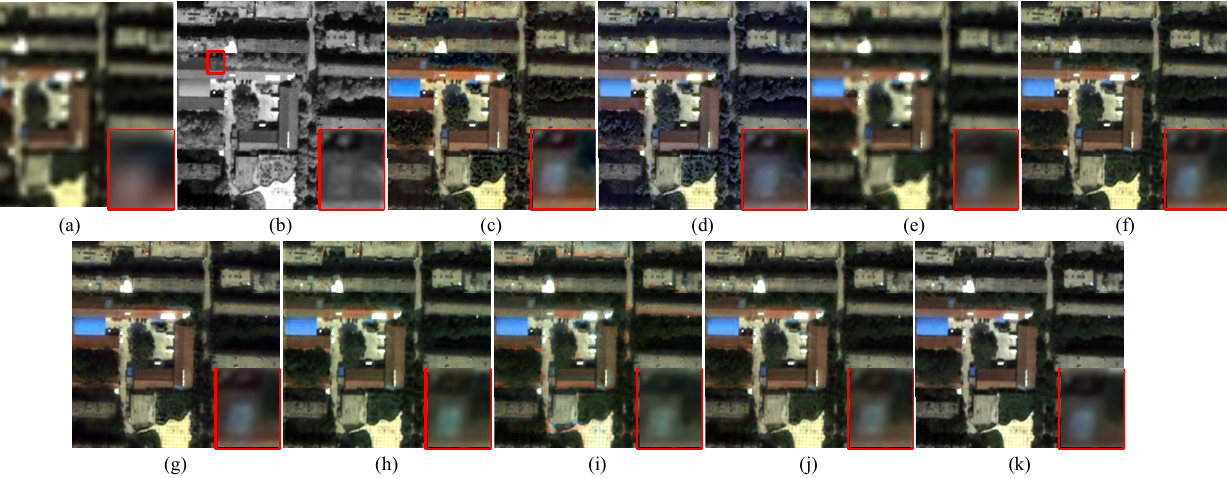
Figure 8. Visual analysis of the fused images from different methods on the QuickBird dataset. ( a ) LR MS image; ( b ) PAN image; ( c ) BDSD; ( d ) SVT; ( e ) VPLGC; ( f ) A-PNN; ( g ) DRPNN; ( h ) PanNet;